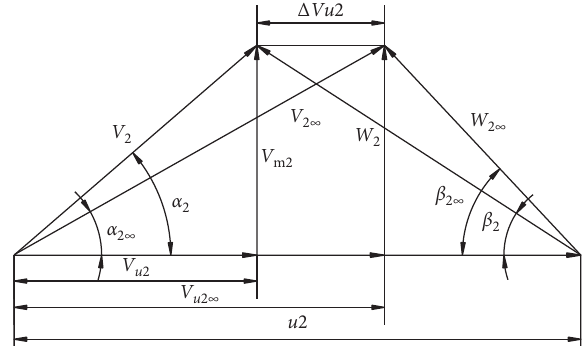
Figure 1: Impeller outlet velocity